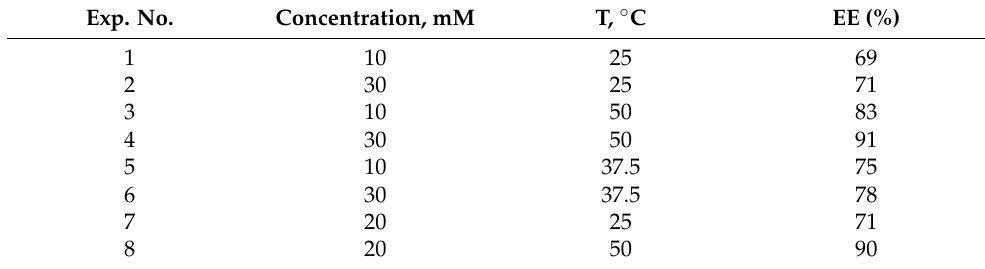
Table 2. Batch LLE optimization studies using the central composite face-centered design algorithm implemented in MODDE 9.1.1. Concentration and the temperature were simultaneously varied. Exp. No. Concentration,